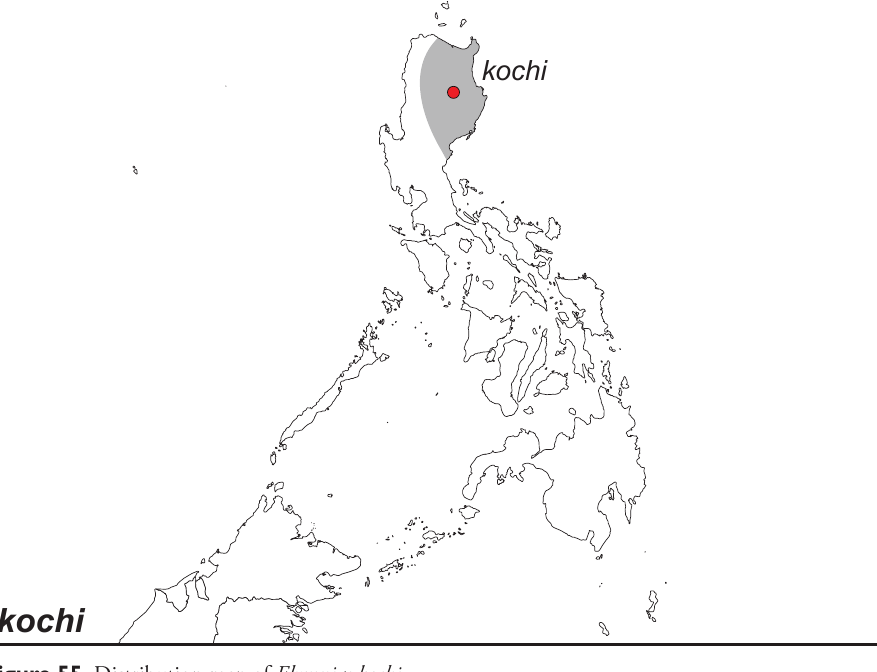
Figure 55. Distribution map of Elymnias kochi .